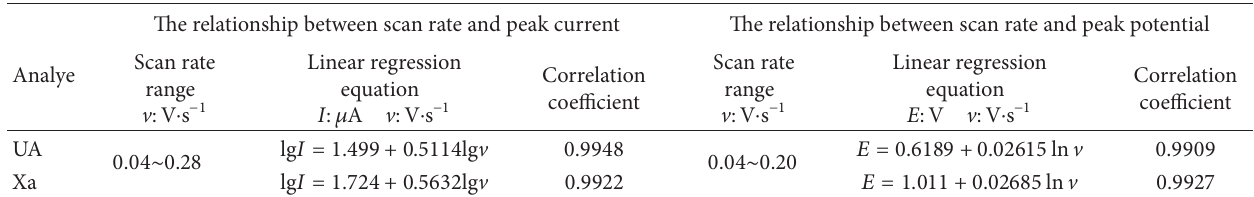
Table 3: The relationship between scan rate, peak current, and peak potential.